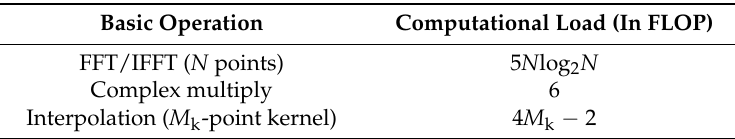
Table 1. Computational load of basic operations.